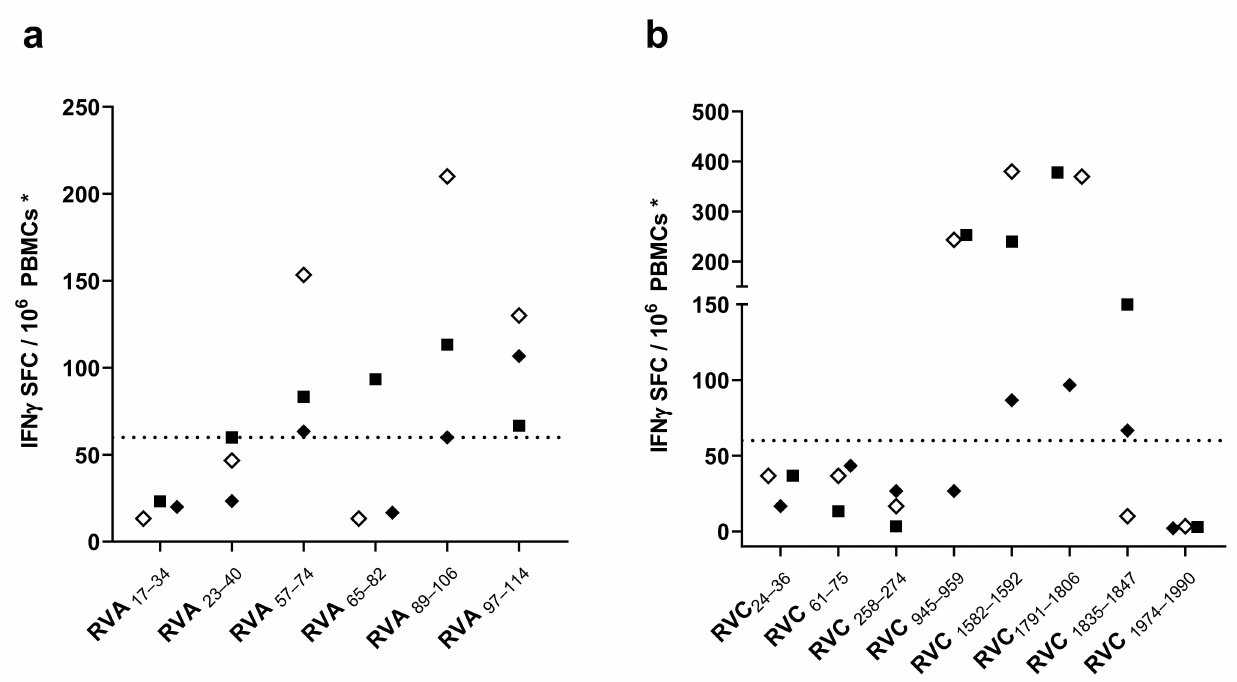
Figure 1. T cell responses to conserved rhinovirus (RV) A and C peptides. ( a ) Recall T cell responses to 18-mer overlapping peptides contained in VP4 protein from RV A. ( b ) Recall T cell responses to conserved 12–17-mer RV C peptides. Recall T cell responses were measured by interferon gamma (IFN γ )-ELISPOT assays in peripheral blood mononuclear cells (PBMCs) from three human leukocyte antigen class II (HLA-II) typed donors, as described in Materials and Methods. Results for each peptide are expressed as the mean of IFN γ spot forming cells (SFCs)/10 6 PBMCs in each subject after subtracting the mean ± standard deviation of the background control. Each individual symbol represents results for the corresponding donor (Donor #1: empty diamond, Donor #2: filled square, Donor #3: filled diamond). The horizontal line represents the threshold used for positive responses (>60 SFC/10 6 PBMCs). We found that 8 out of 14 peptides were able to elicit a positive IFN γ recall response in at least one